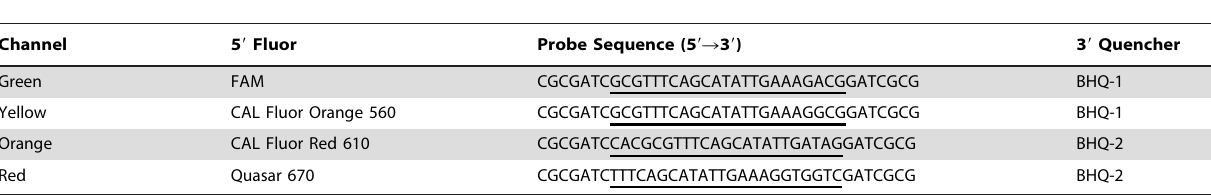
Table 2. Probe sequences for the DENV multiplex rRT-PCR.